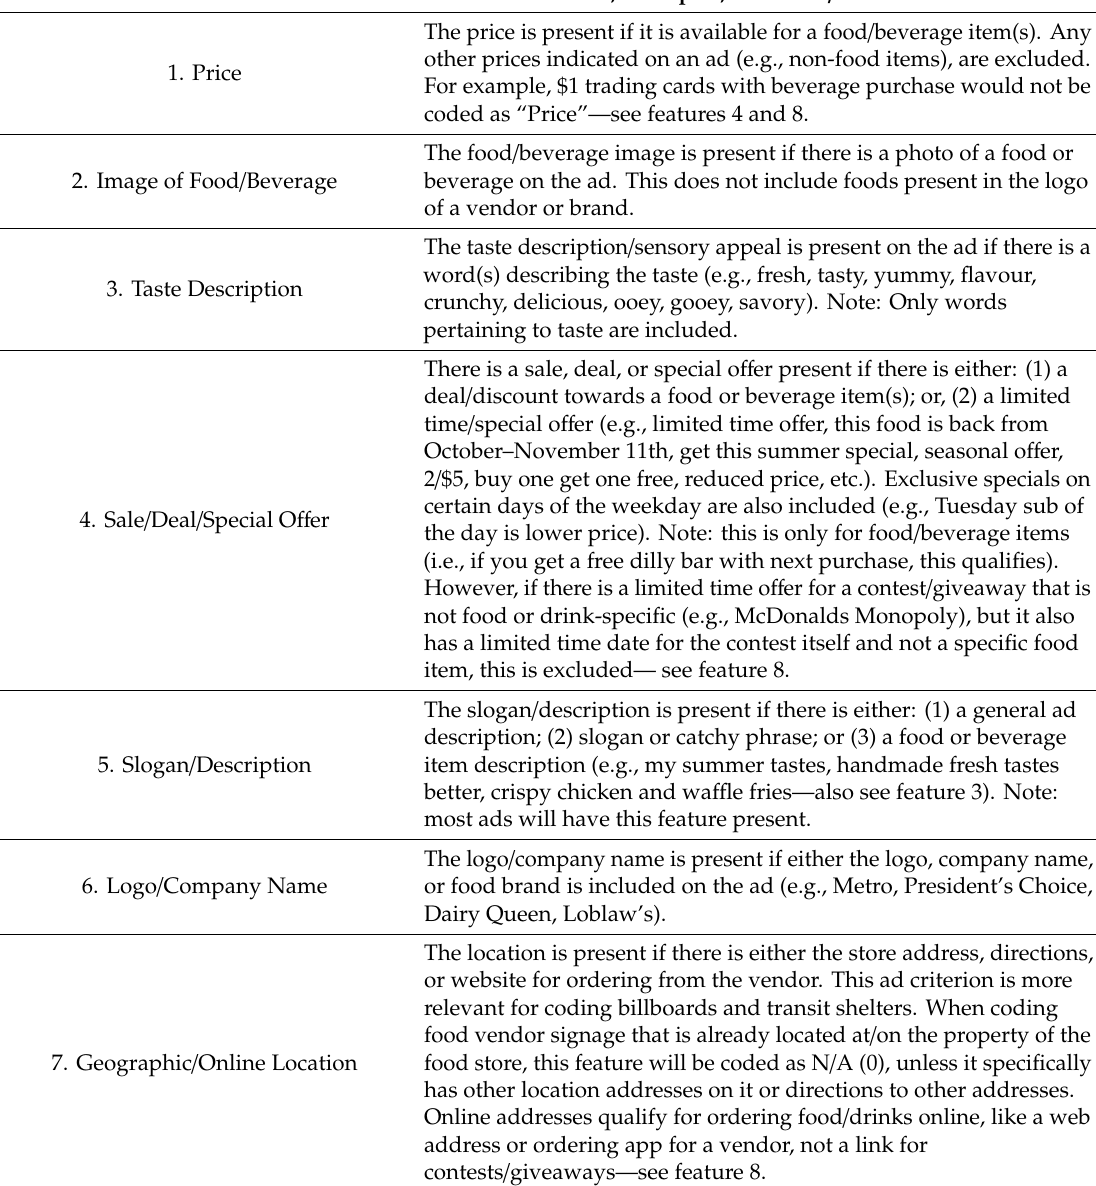
Table 1. Teen-developed coding